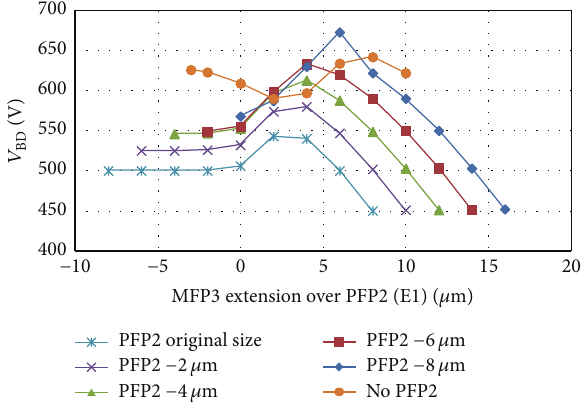
Figure 8: Breakdown voltage related to MFP3 extension over PFP2 ( 𝐸1 ) for different PFP2